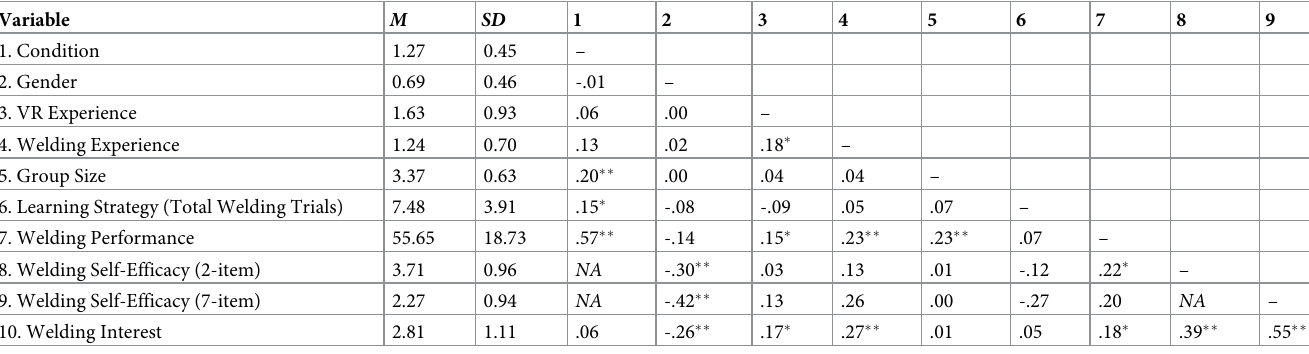
Table 3. Means, standard deviations, and correlations among Study 2 variables.